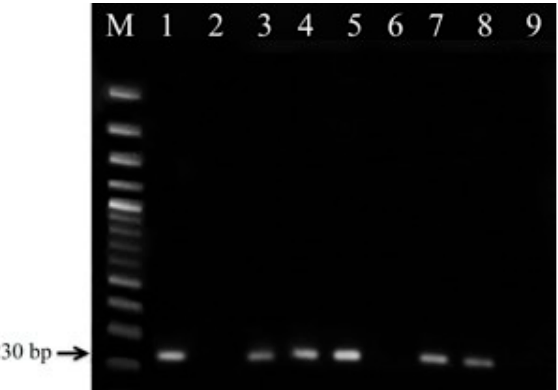
Figure 2. Amplification results with the Mat1-2-specific primer set (PmaleoMat1-2F/PmaleoMat1-2R) using tem- plate DNA from Togninia minima isolates. Lane M, 100 bp DNA ladder; lanes 1, 3–5, 7, 8, Mat 1‒2 isolates; Lanes 2, 6, Mat 1‒1 isolates; Lane 9, negative control (master mix).